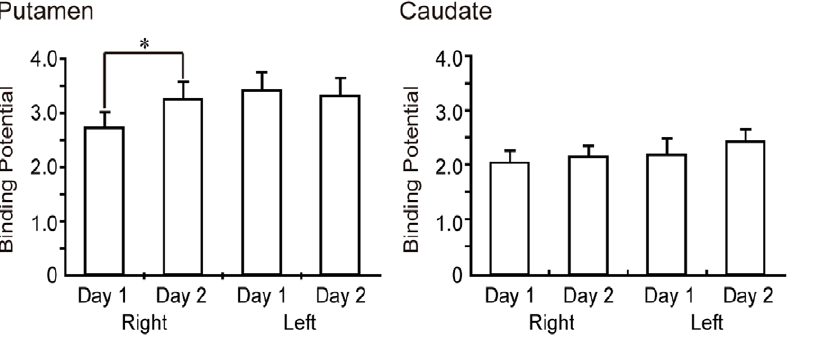
Figure 4. 11 C-raclopride BP changes in the bilateral putamen and caudate nucleus between the two conditions. In the right putamen, 11 C-raclopride BP was significantly reduced during initial skill-training compared with the acquired condition, whereas no significant reduction was observed in the left putamen. In the bilateral caudate, no significant changes were observed between the two conditions. The mean ( 6 SEM) BP during initial skill-training was 2.72 6 0.86 in the right putamen and 3.42 6 0.99 in the left